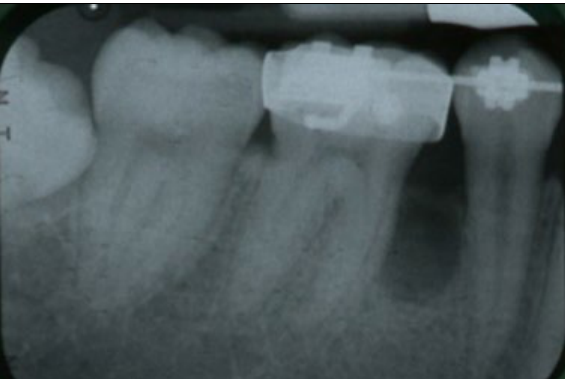
Figure 7. Fifty week progress periapical radiograph of 44–46